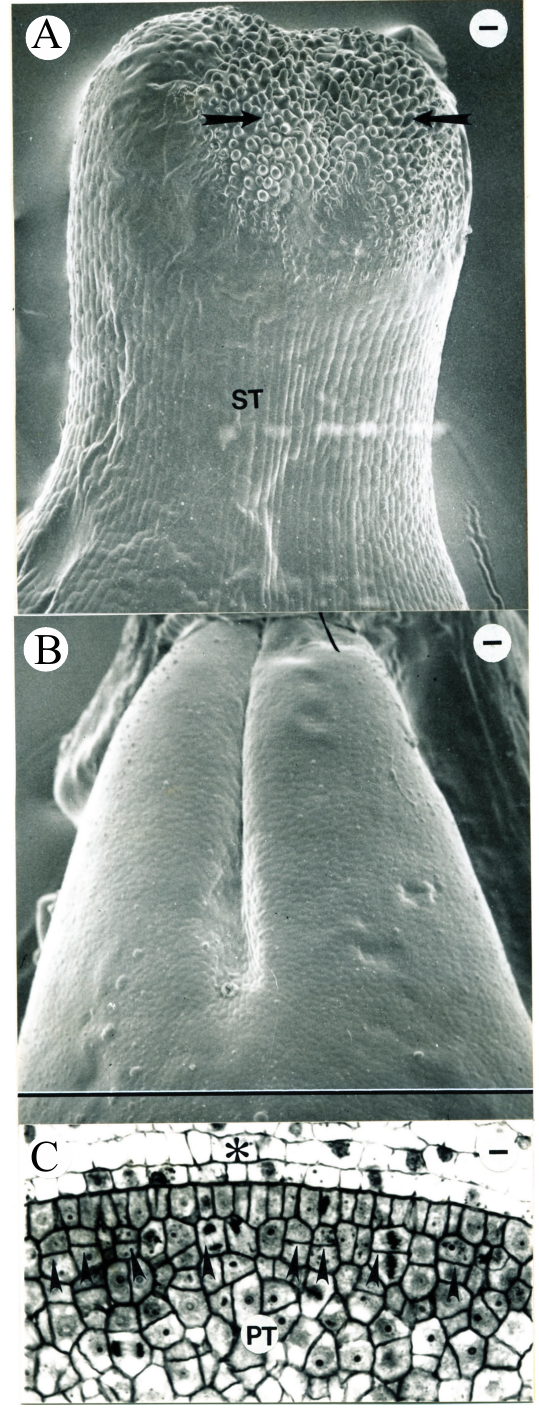
Figure 5. SEM micrographs and a transverse section of tobacco pistil during the 8th day after ECP. ( A ) During the age interval 7.6 ± 1.1 days after ECP, the papillar cells (arrows) are evident on the top of the stigma and the style (ST) begins to elongate. Bar = 20.7 µ m. ( B ) SEM micrograph of the placenta in the same pistil seen in ( A ) with the carpel wall removed showing no morphological evidence of ovule initiation. The line indicates the approximate orientation of the corresponding histological section shown in ( C ). Bar = 18 µ m. ( C ) Transverse section of a placenta at a developmental stage similar to that seen in ( B ). Periclinal divisions in L2 in the placenta are now common (arrowheads). The carpel wall is identified by an asterisk. Bar = 7.2 µ